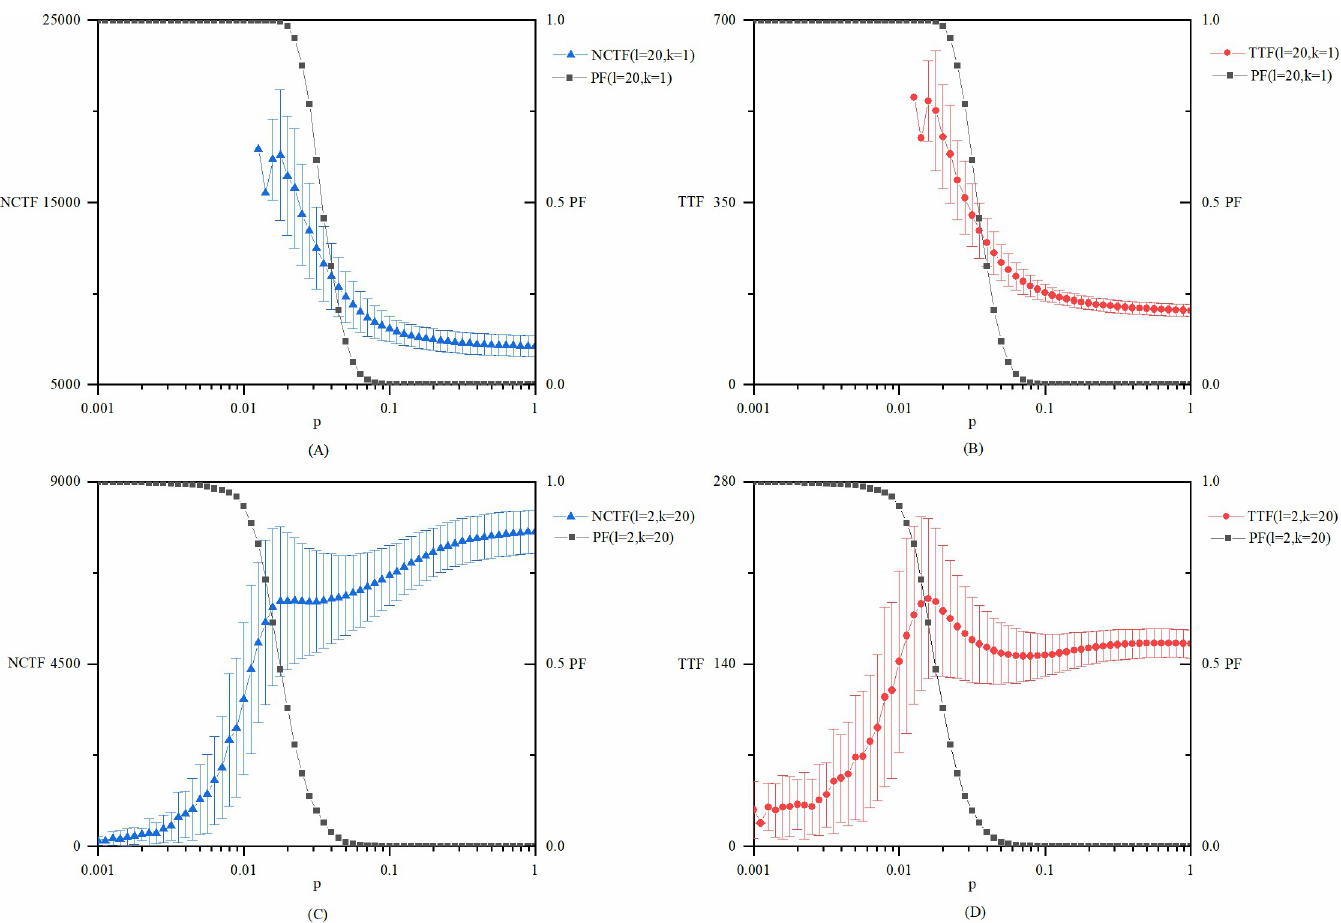
Fig 8. The model results with dv as a certain proportion of the knowledge difference between the two nodes. (A) NCTF and PF of explorative innovation. (B) TTF and PF of explorative innovation. (C) NCTF and PF of exploitative innovation. (D) TTF and PF of exploitative innovation. Specifically, the value of dv = 0.2| v in this